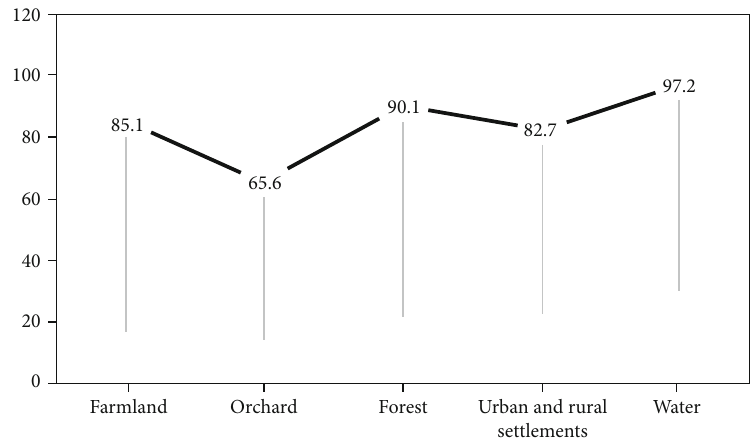
Figure 4: ROC values for each logistic